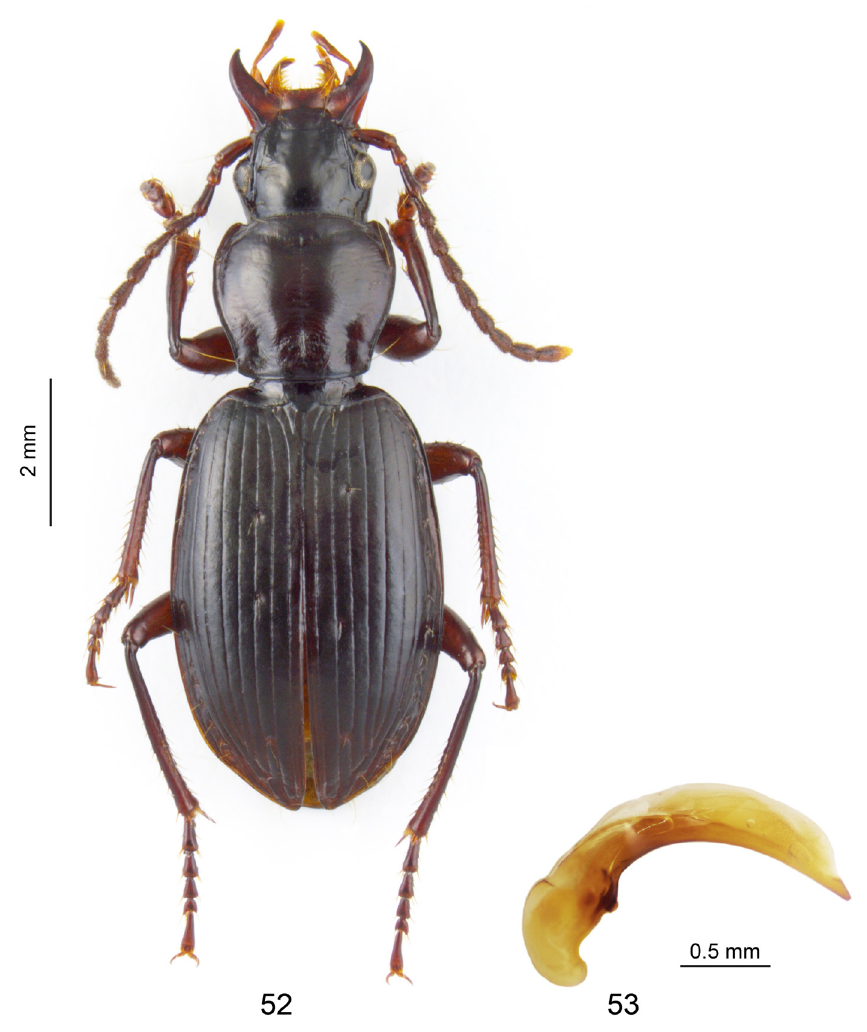
Figs 52–53. Dyscolus silvestris Moret sp. nov., male holotype (QCAZ). 52 . Habitus. 53 . Male aedeagus, median lobe in lateral